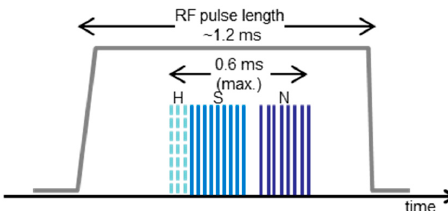
Figure 2. Time pattern of the electron bunch train in the linac. The RF field is pulsed with 10 Hz and has a flat top region of ~1.2 ms clearly exceeding the duration of the electron bunch train of 600 µ s. The bunch train can be separated into portions with different function. The header H is typically used for fast intra-bunch feedback. The next portion S is dedicated for the South branch with SASE2. Following a short gap to switch the flat top kicker magnet the last portion N will be send to the North branch with SASE1 and SASE3. The smallest separation of electron bunches is 222 ns in standard operation, corresponding to 4.514 MHz and up to 2700 bunches per train. Operation at bunch separations of 886 ns (1.128 MHz) and 10 µ s (0.1 MHz) is possible,